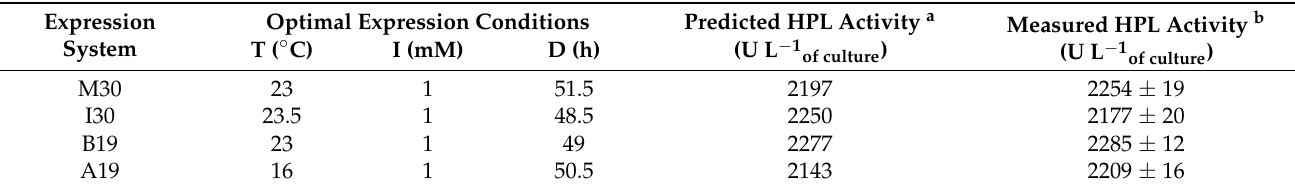
Factors are coded as follows: temperature (T), inducer concentration (I), induction duration (D); a activity predicted by RSM analysis for 2 mL production in microplates; b two-milliliter production in microplates for experimental validation. Measured activity in the optimal conditions predicted by RSM